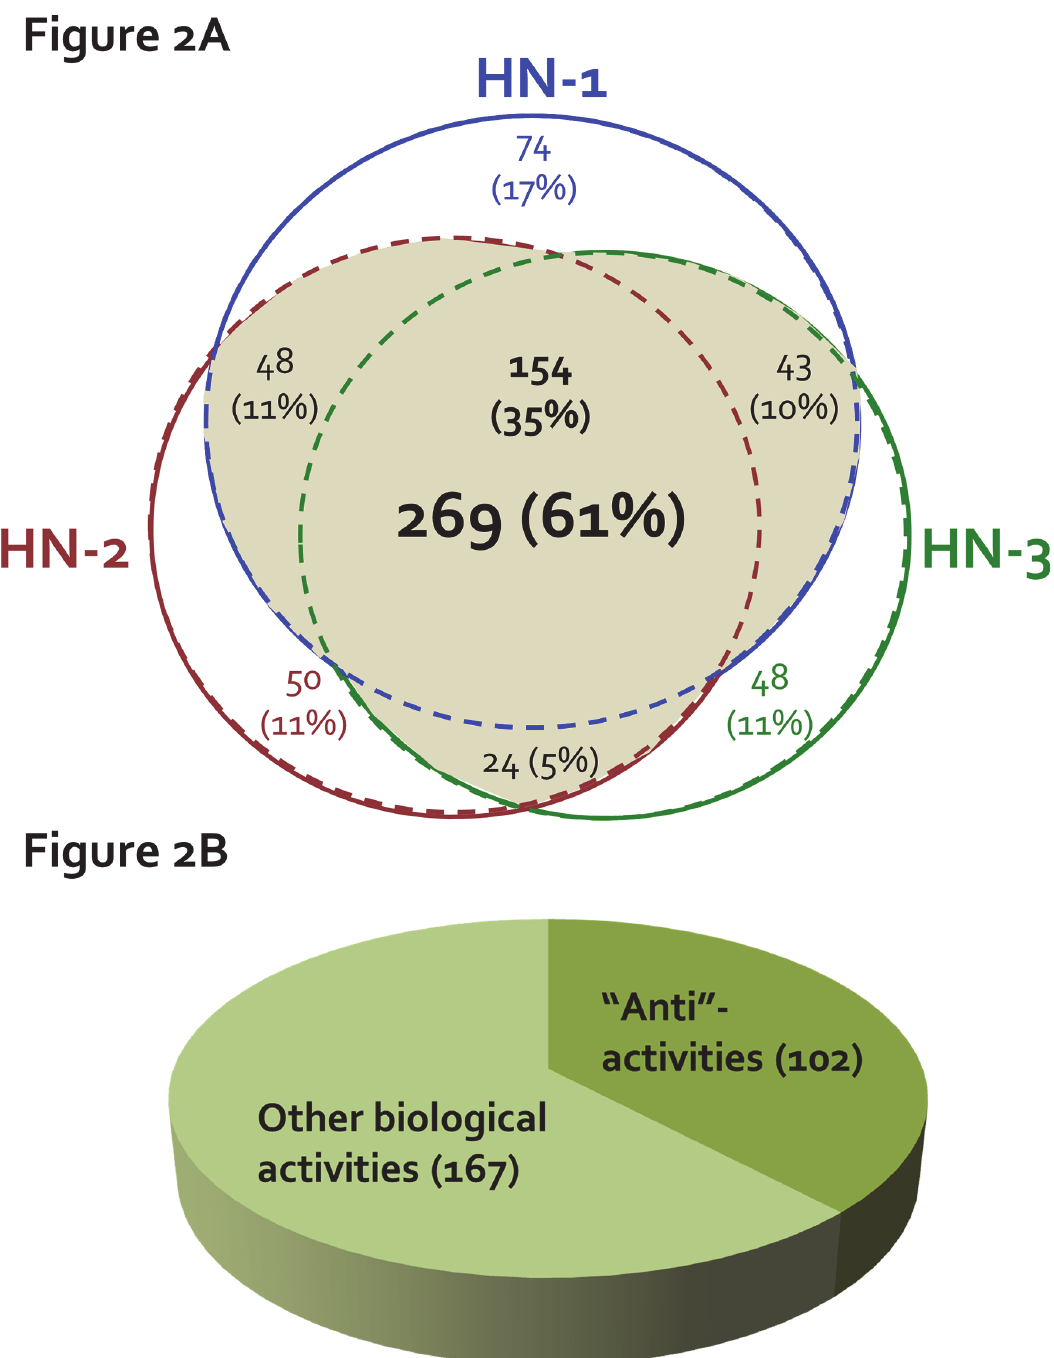
Fig 2. Proteins identified in human tracheal submucosal gland mucus by LC-MS/MS. (A) A modified Venn diagram of showing distribution of proteins among three healthy human (HN) donors. Across the 3 donors, 5486 peptides and 441 proteins were identified. Of these, 61% (269 proteins, the shaded area) and 35% (154 proteins) were found in 2 – 3 and all 3 HN gland mucus samples, respectively. (B) Among these 269 proteins, 102 (38%) were categorized as proteins with “ anti ” -activities: antimicrobial, antiinflammatory, antiproteolytic and antioxidant. Other biological activities include: biological regulation, metabolic/multi-organismal/developmental processes, binding activity, and establishment of localization.